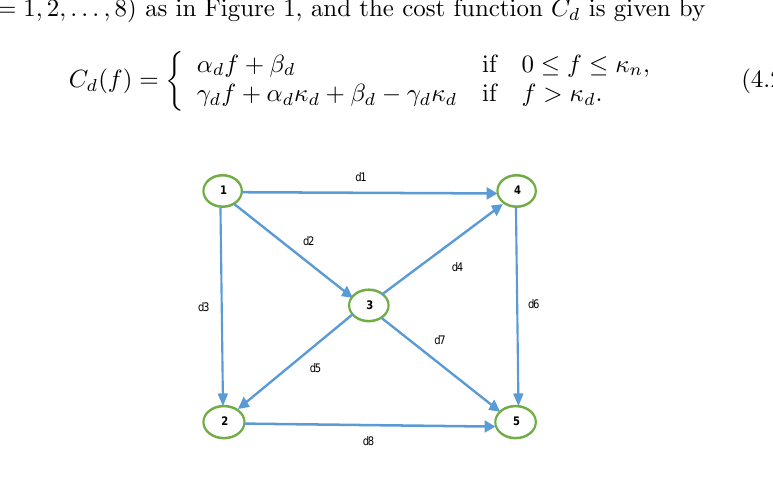
Figure 1. Traffic network with 5 nodes.